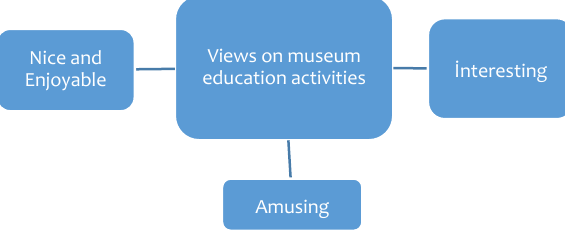
Figure 3. The Perspective Elementary School Teachers’ Views on Museum Education Activities